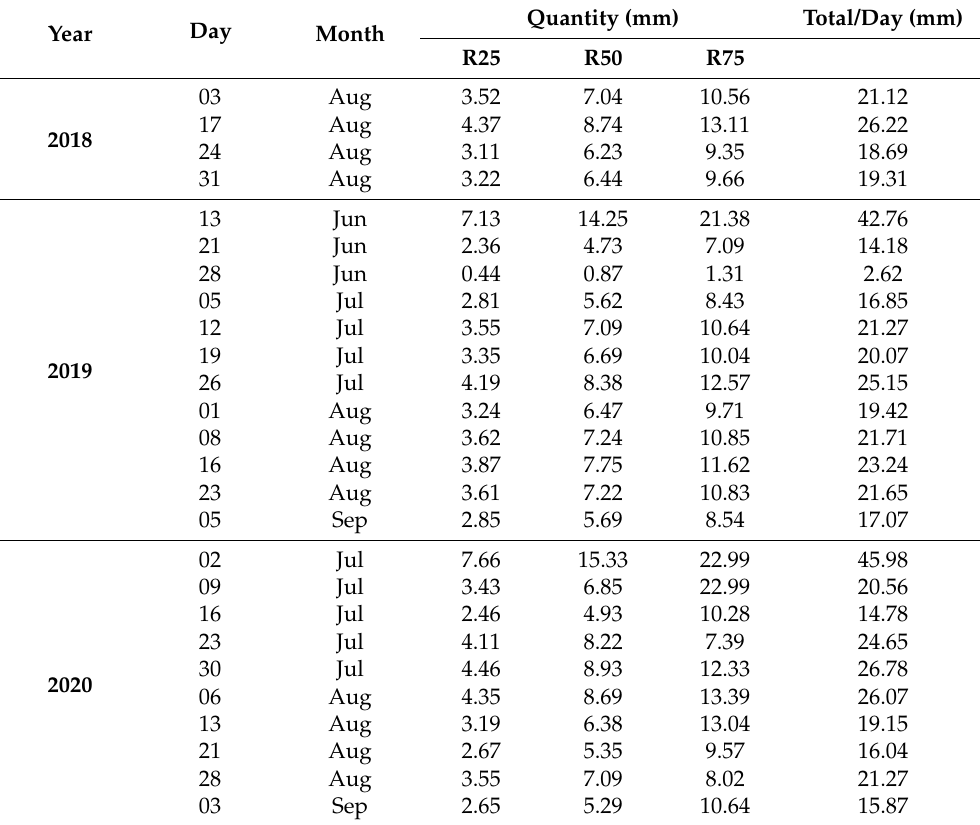
Table A1. Day of irrigation and irrigation quantity (mm) in each treatment during each season in the Douro superior